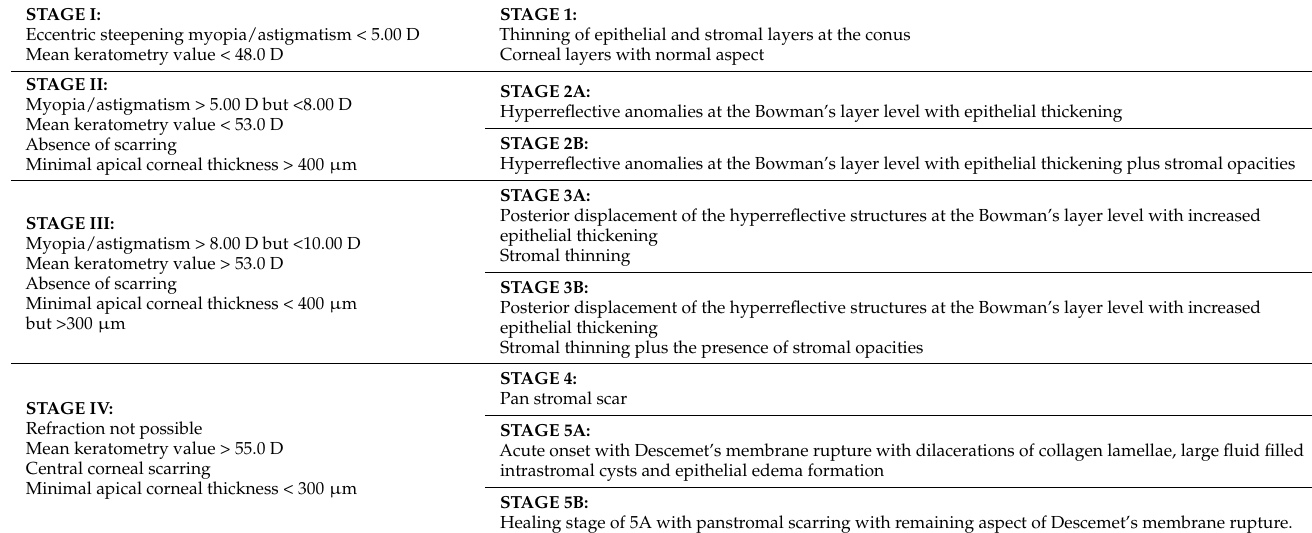
Table 1. Comparison of the Amsler–Krumeich and Sandali classifications.